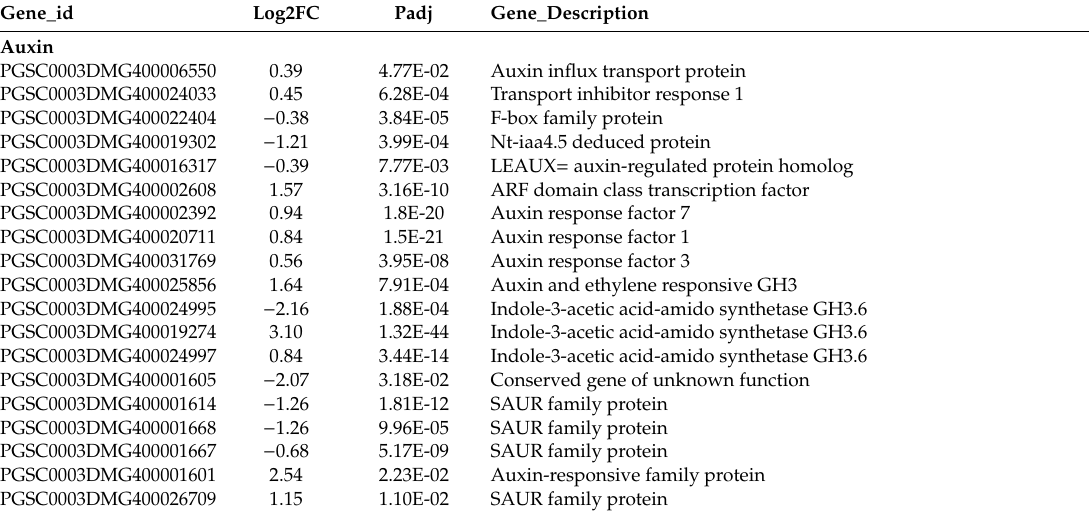
Figure 6. StABI5 involved in plant hormone signal transduction in potato. DEGs of plant hormone signals transduction were marked in StABI5 vs. De group. Green boxes represent down-regulated genes, red boxes indicate up-regulated genes, and yellow boxes represent both up- and down-regulated genes. Table 3. DEGs of plant hormone signals transduction in StABI5 vs. De